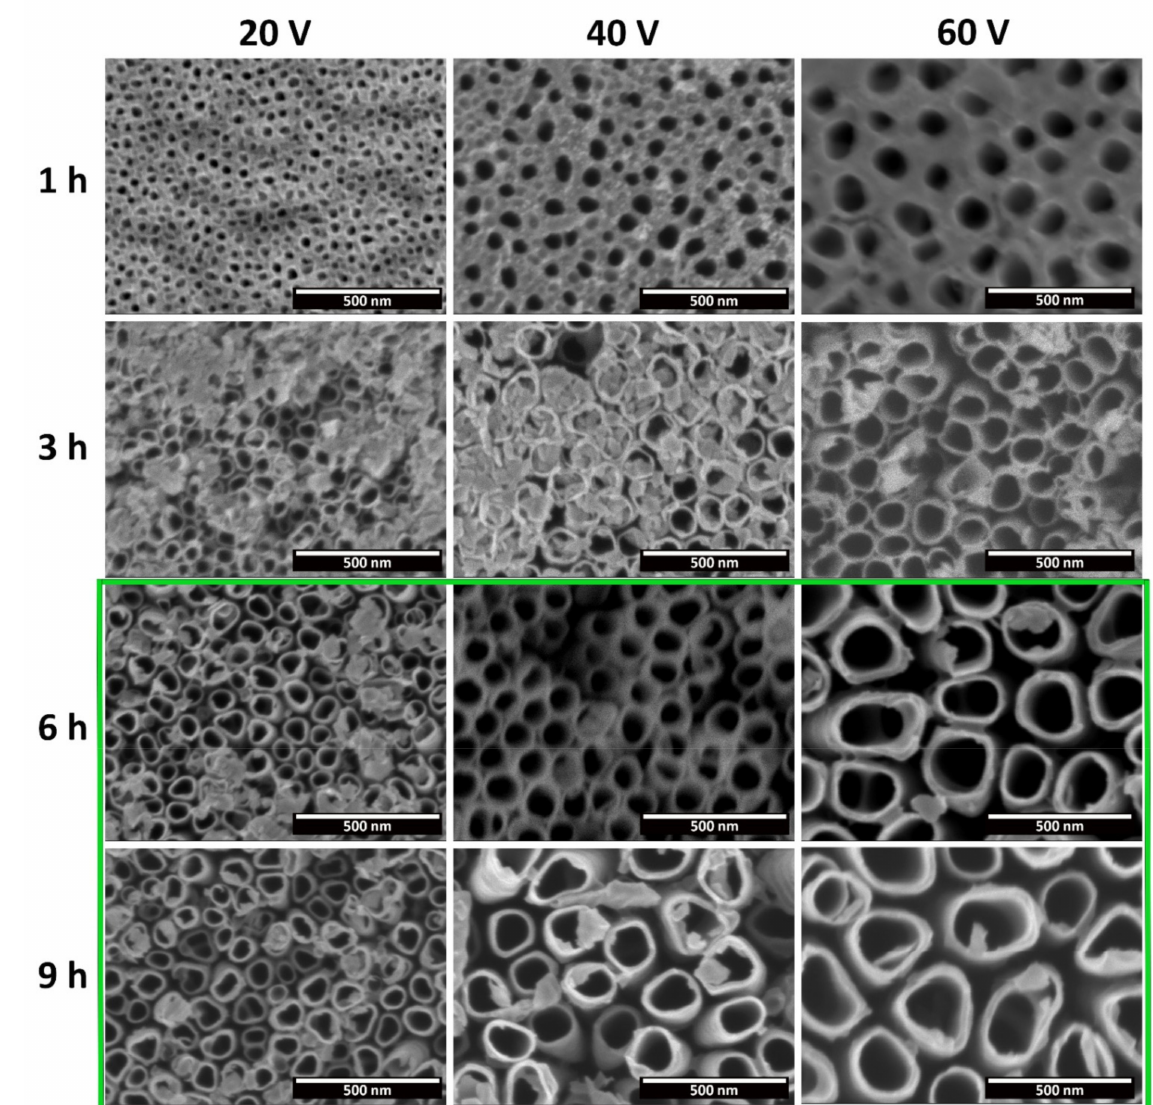
Figure 8. FESEM micrographs depicting a top view of the anodic oxide layer produced through electrochemical anodization in a CP-Ti substrate, at different applied potentials and times, at a higher magnification. The green frame highlights the conditions with open-top